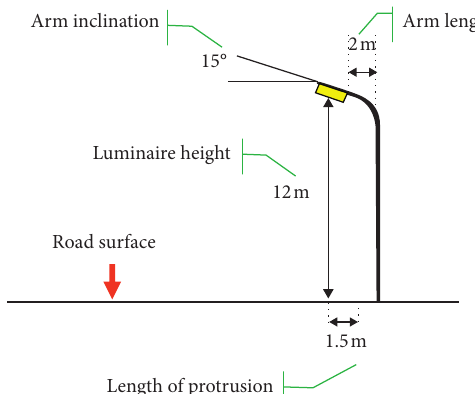
Figure 6: Drawing of lighting environment parameters for design of luminaire of streetlight.